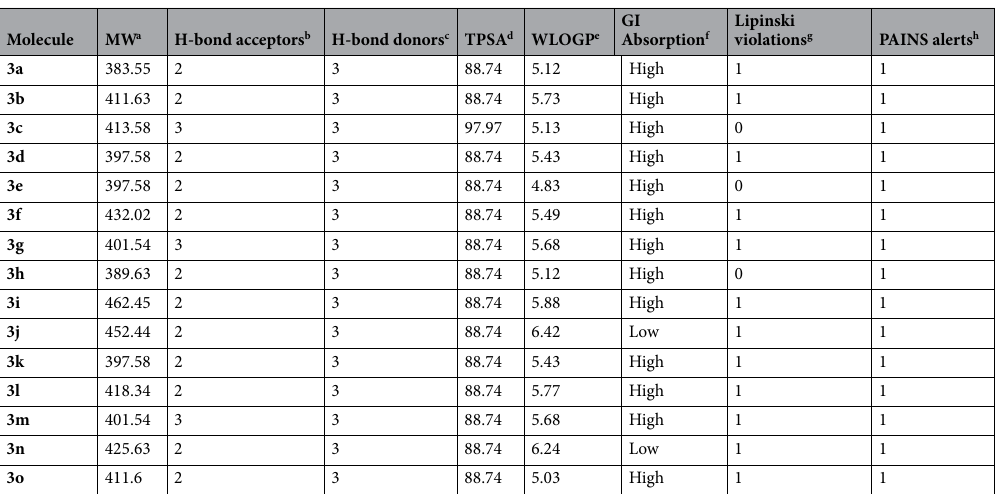
Table 3. ADME evaluation of 3a - o . a Molecular weight. b Hydrogen bond acceptor. c Hydrogen bond donor. d Total polar surface area. e Logarithm of partition coefficient between n-octanol and water. f Gastrointestinal absorption. g Violations of Lipinski’s rule of five. h PAINS (Pan-assay interference compounds) alert. Synthesized compounds’ codes were written in bold